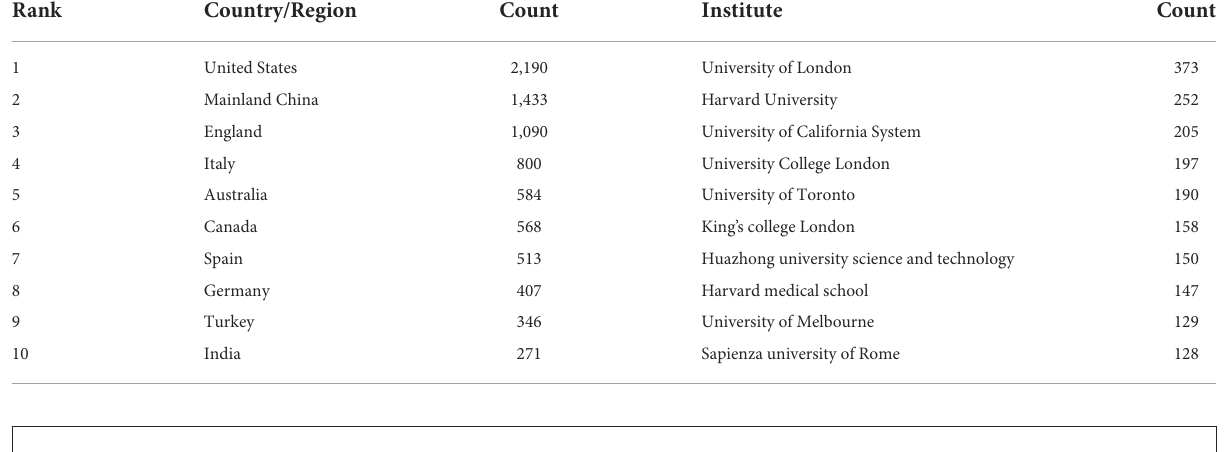
TABLE 3 Top 10 countries and institutes in the number of articles.